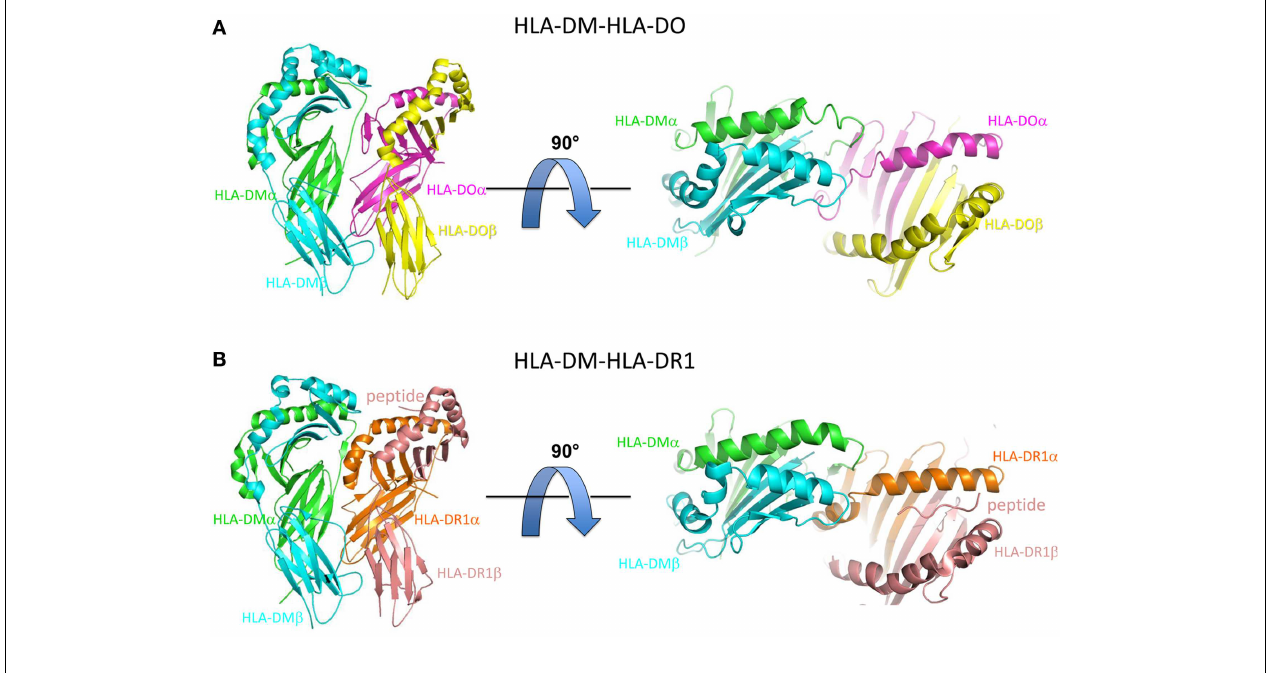
(right) of HLA-DM-HLA-DR1 structure (PDB ID: 4FQX). HLA-DM is colored the same, HLA-DR1 α orange, and HLA-DR1 β magenta.The peptide (colored magenta) is located in the C-terminal end of the peptide binding